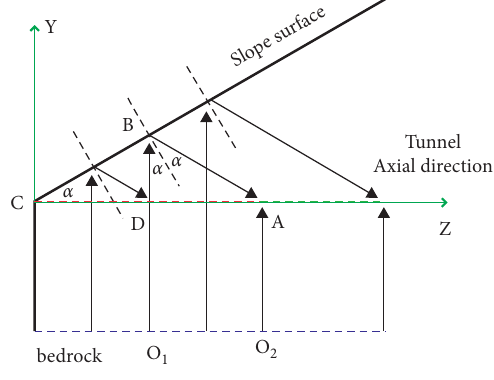
Figure 1: SH wave propagation